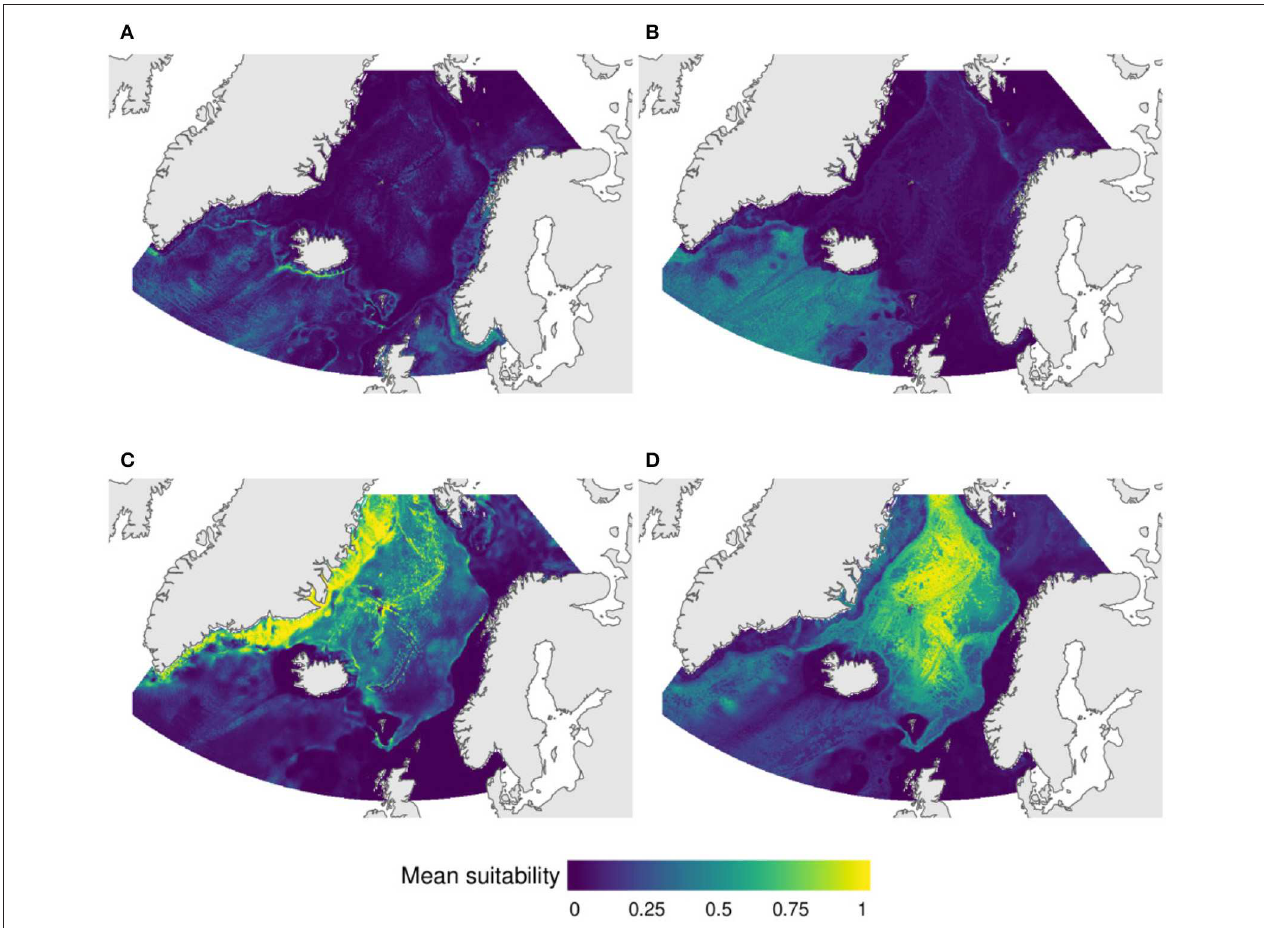
FIGURE 5 | Predicted distribution of VMEs based on stacked species distribution model (SSMD) of (A) the sea pens Funiculina sp., Pennatula sp., Kophobelemnon sp., and Halipteris sp., (B) the gorgonians Anthotella grandiflora ,/Radicipes/ sp. and Anthomastus sp., the deep-water sea pen Anthoptilum sp., the cup coral Flabellum sp., and the reef-forming coral Solenosmilia variabilis , (C) the sponges Geodia parva and G. hentschelli , and (D) the sponges Caulophacus (C.) arcticus , Chladorhiza sp., and Lycopodina